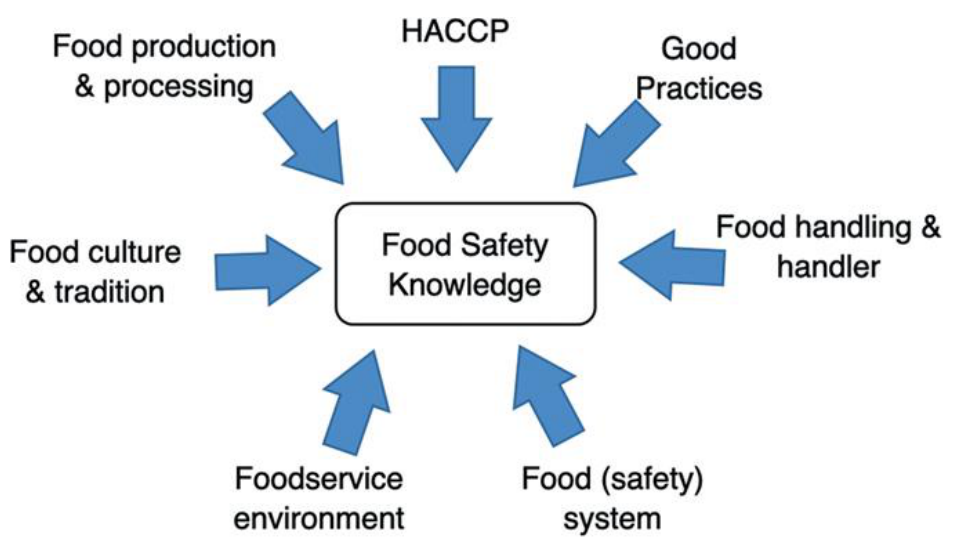
Figure 2. Key direct/indirect components that influence food safety knowledge (Source: Okpala and Korzeniowska [3]; Permission to use given by Taylor and Francis Ltd.).